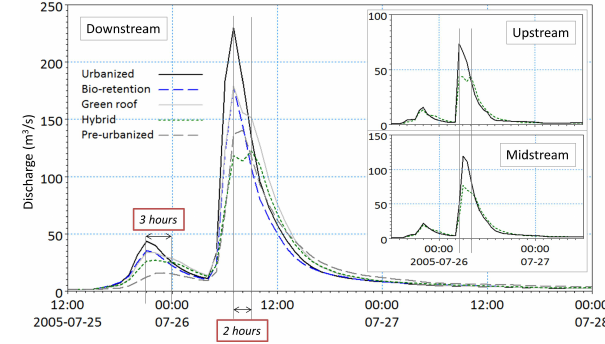
Fig. 7. Delay of peak discharges for different sections (i.e. down- stream, midstream and upstream) of the main river of